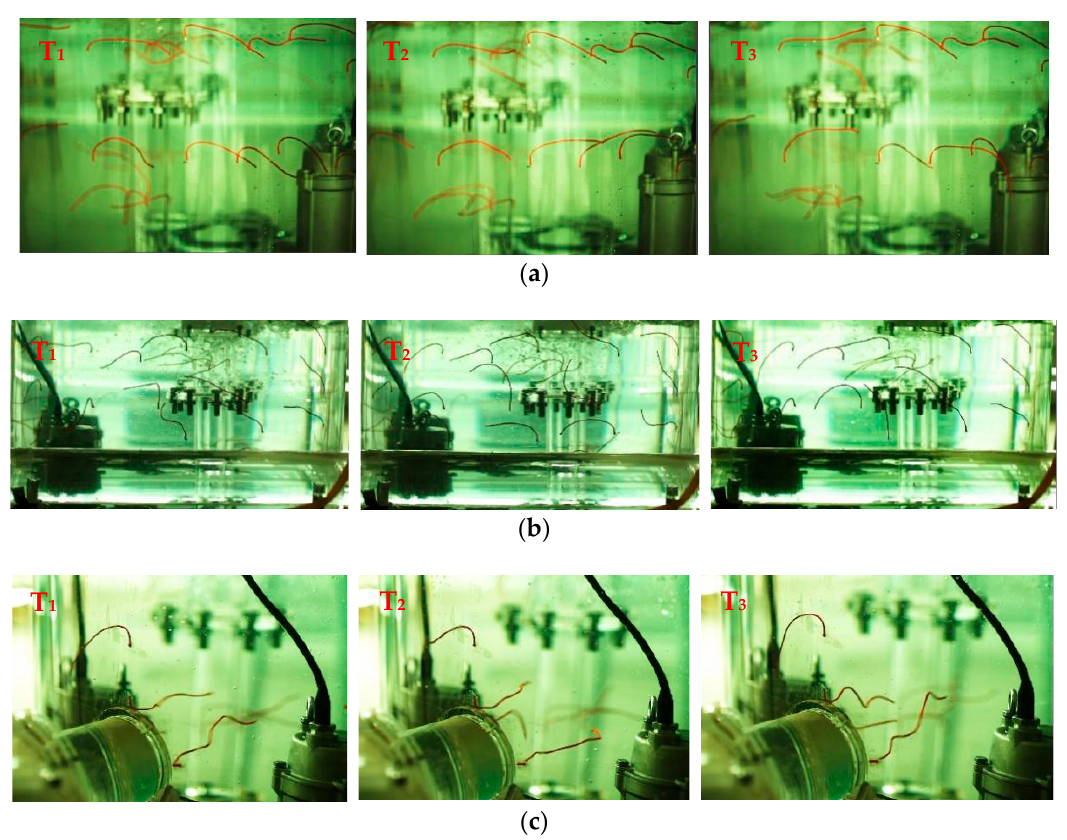
Figure 15. Flow pattern of prefabricated pumping station. ( a ) Left side of prefabricated barrel; ( b ) right side of prefabricated barrel; ( c ) filming at the inlet of the prefabricated barrel.